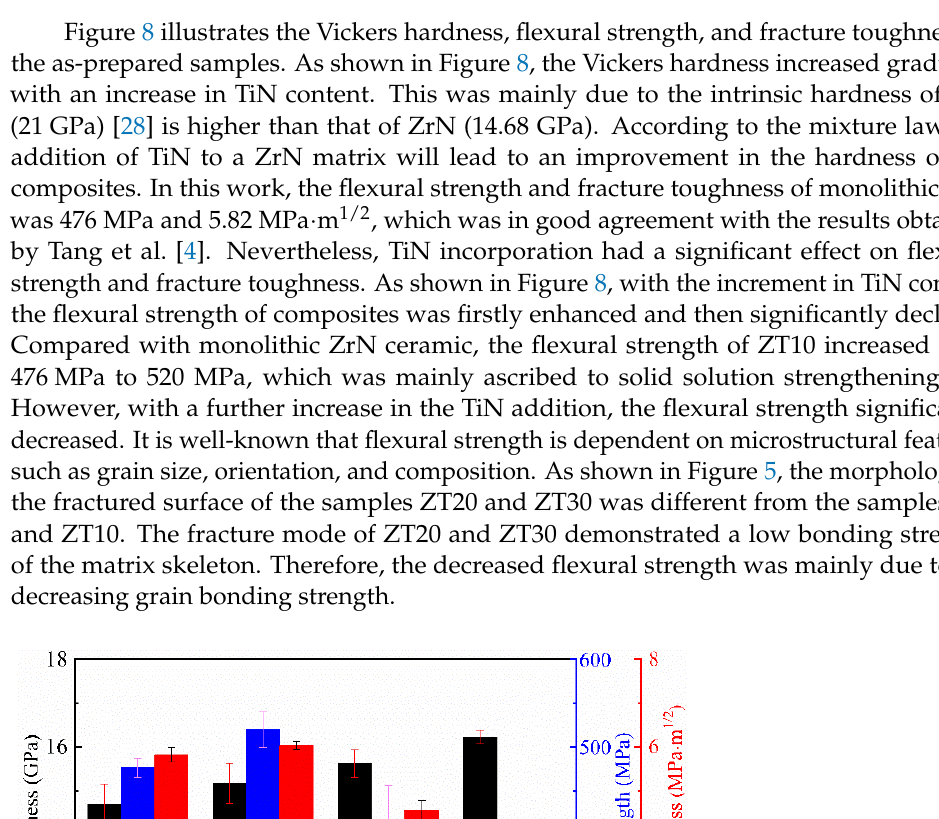
Figure 9. The crack propagation of sample ZT10.